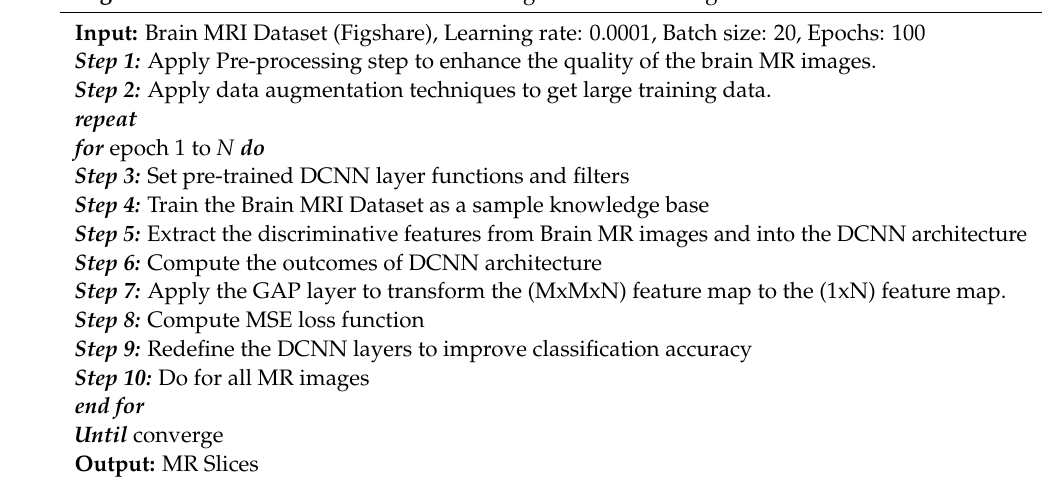
Algorithm 1: Brain Tumor Classification using Transfer Learning